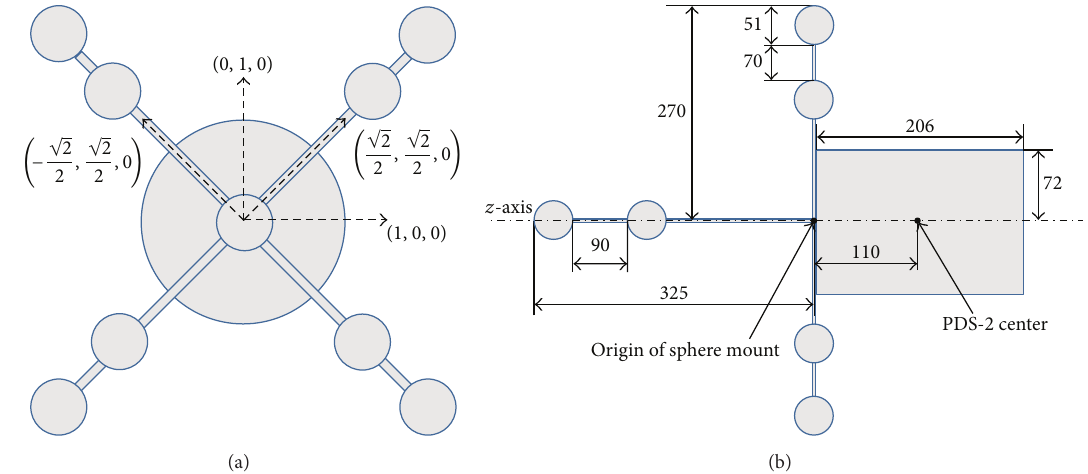
Figure 3: (a) Relative alignment of the predefined axes of the cylindrical PDS-2 phantom and the depth calibration structure with the unit direction vectors in the Zeego coordinate system. (b) The origin of the depth calibration structure aligns with the center of the PDS-2 phantom along the 𝑧